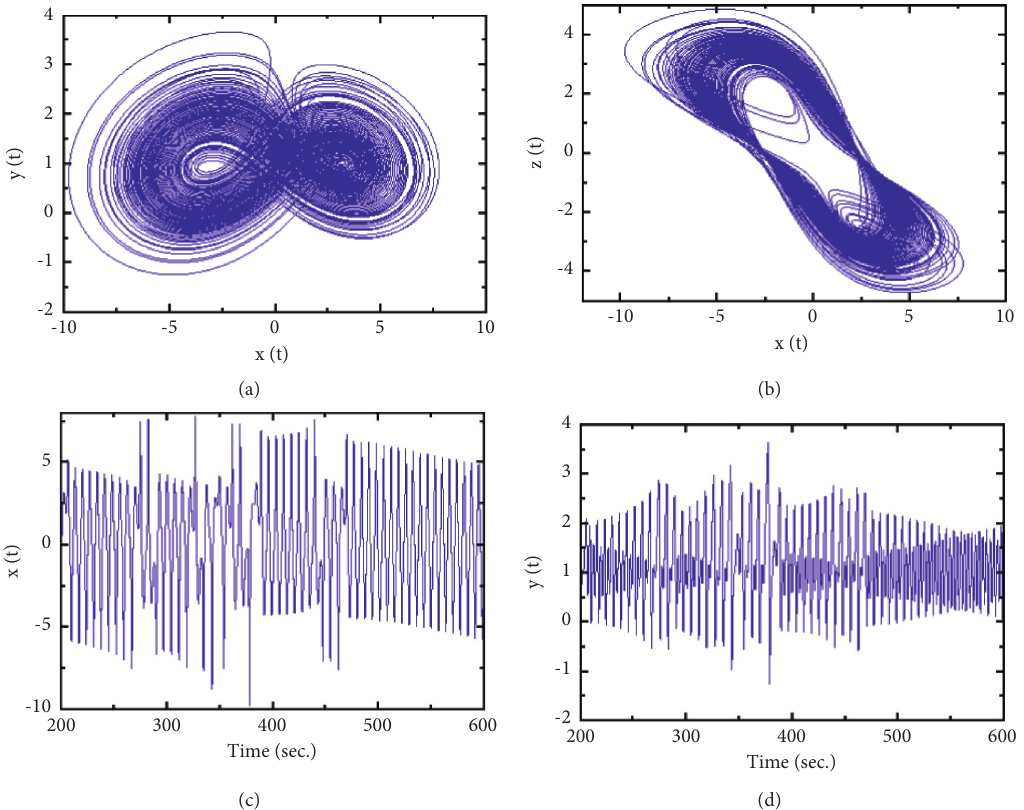
� 1 , q � 0 . 88 , and q � 1: (a) projected onto the x − y phase plane, 1 2 3